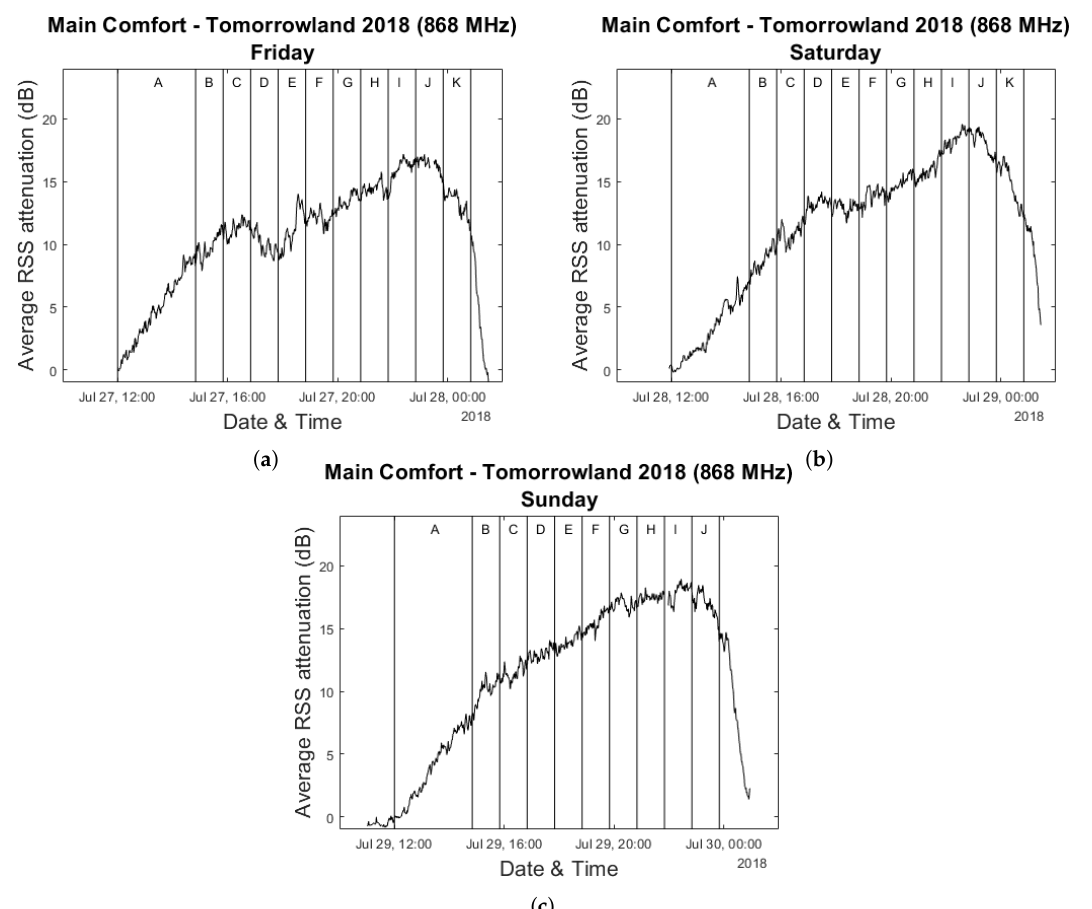
Figure 4. Evolution of the average RSS attenuation within the Main Comfort Environment throughout the festival weekend. ( a – c ) show this for respectively Friday 27 July 2018, Saturday 28 July 2018 and Sunday 29 July